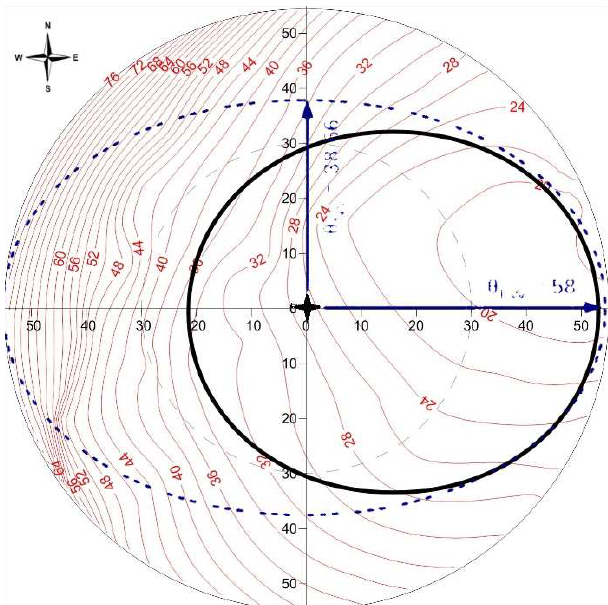
Fig. 4. The local map and the projection of the view angle of the J´ozsef Mountain above the Moln´ar J´anos Cave. The detector was placed at the origo within the west–east orientational artificial cav- ern. Dashed blue lines are for the whole view angle of the muon tomograph, while solid black lines shows the region useable for the relief reconstruction. Red contours show the thickness of the mate- rial in meter soil equivalent (m.s.e.).